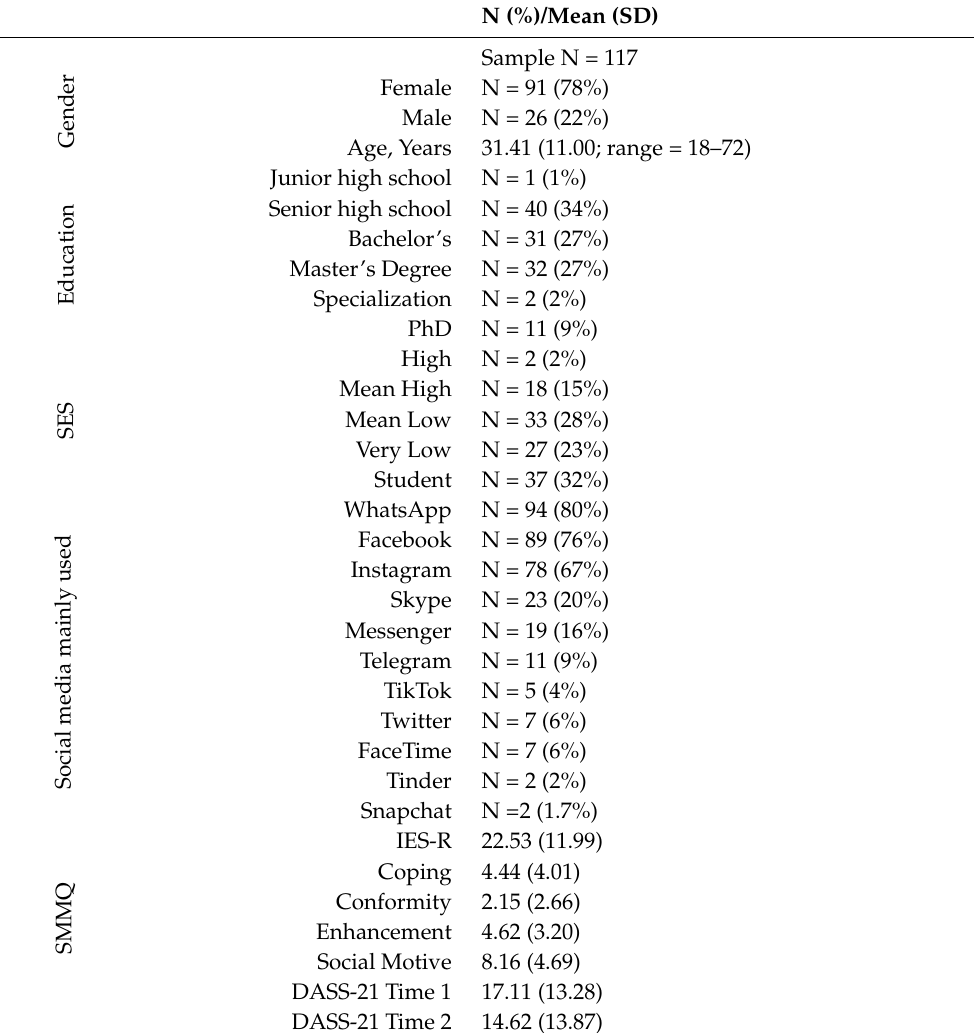
List of abbreviations: SES = Socioeconomic Status; IES-R = Impact of Event Scale-Revised; SMMQ = Social Media Motives Questionnaire; DASS-21 = Depression Anxiety Stress